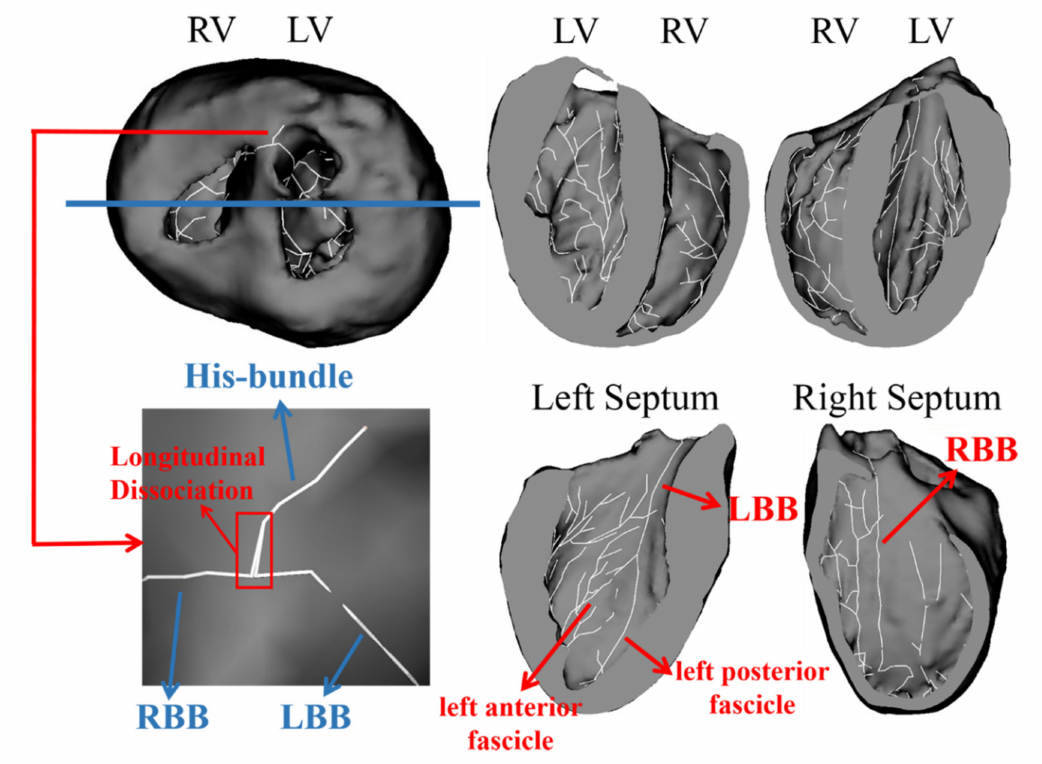
Figure 1. Rabbit ventricular electrophysiological model with His-Purkinje system model. The cross section is the blue line in the top view. The gray part represents the myocardium, and the white network represents the His-Purkinje network model. The longitudinal association structure is shown in detail. RV: Right ventricle. LV: Left Ventricle. RBB: Right bundle branch. LBB: Left bundle